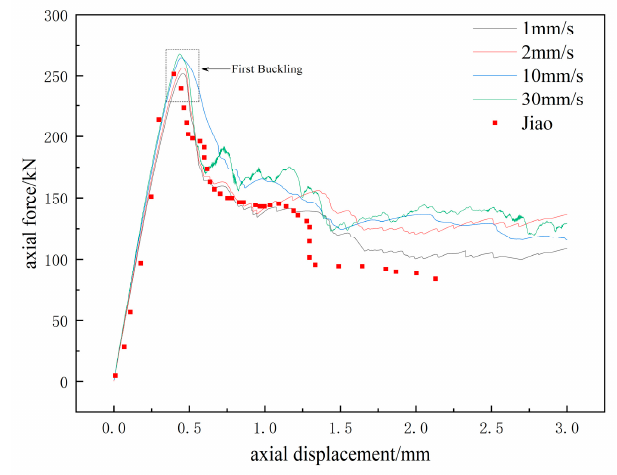
Figure 7. Displacement-load curves under different loading